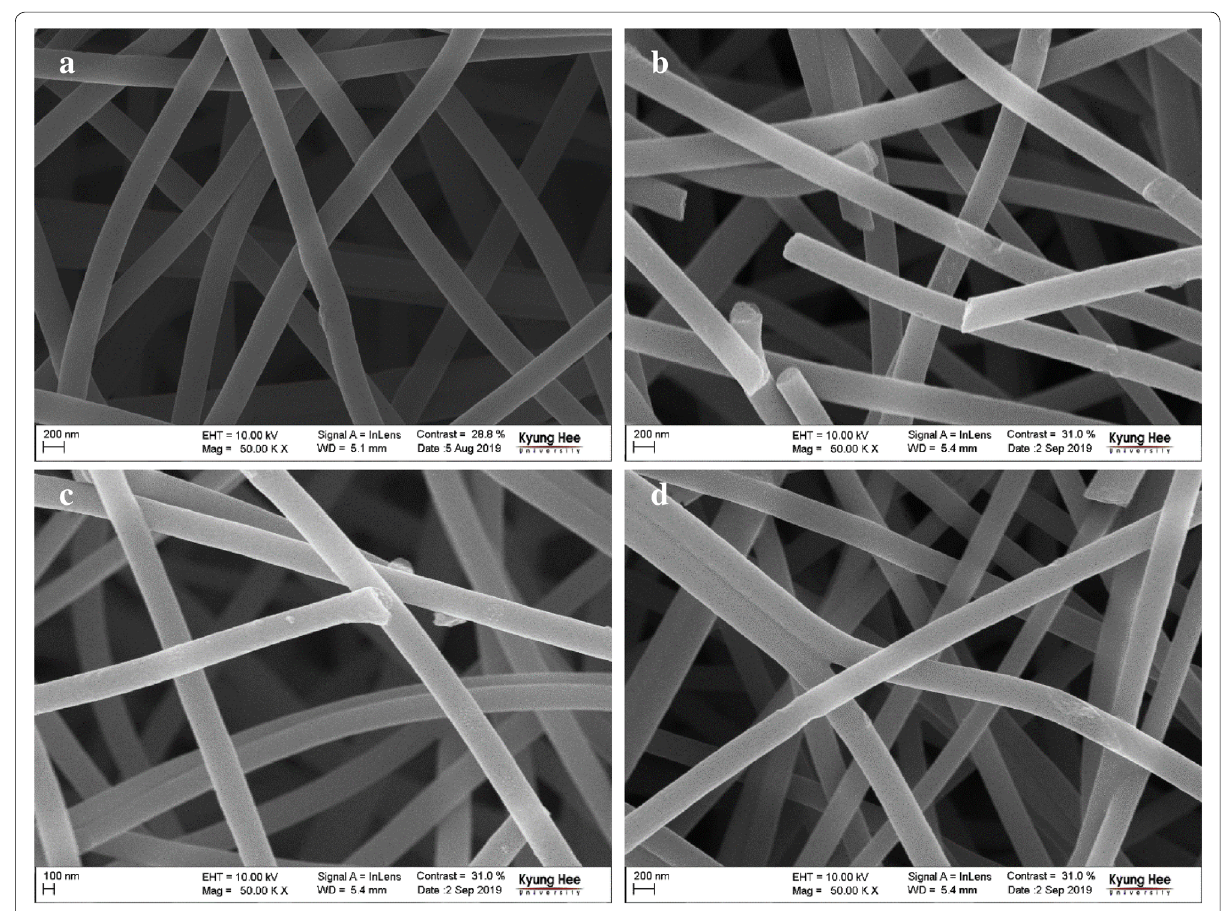
Fig. 3 FE-SEM images of a 60-ANF; b 60-ANF-TEPA; c 60-ANF-HNO 3 ; d 60-ANF-HNO 3 -TEPA